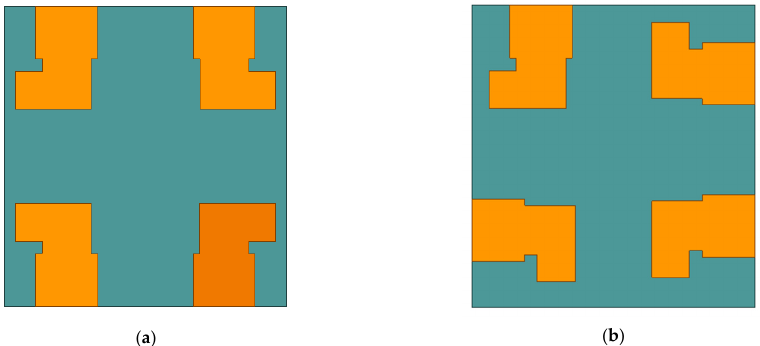
Figure 6. Four-element configuration variations for better isolation ( a ) case-I and ( b ) case-II. Simulation was conducted to determine the transmission coefficient of the ports of the MIMO antenna, and the simulation result for design 1 (Figure 6a) and design 2 (Figure 6b) is shown in Figure 7. The simulation result for configuration 1 for the transmission coefficient is shown in Figure 7a. This shows that the isolation between first and second elements, as well as third and fourth elements, is less than 10 dB from the frequency range of 34 GHz to 40 GHz. To enhance the isolation, the position of the fourth element is changed as shown in Figure 6b. The position of the fourth element is changed, and the corresponding simulation result for the antenna is depicted in Figure 7b.